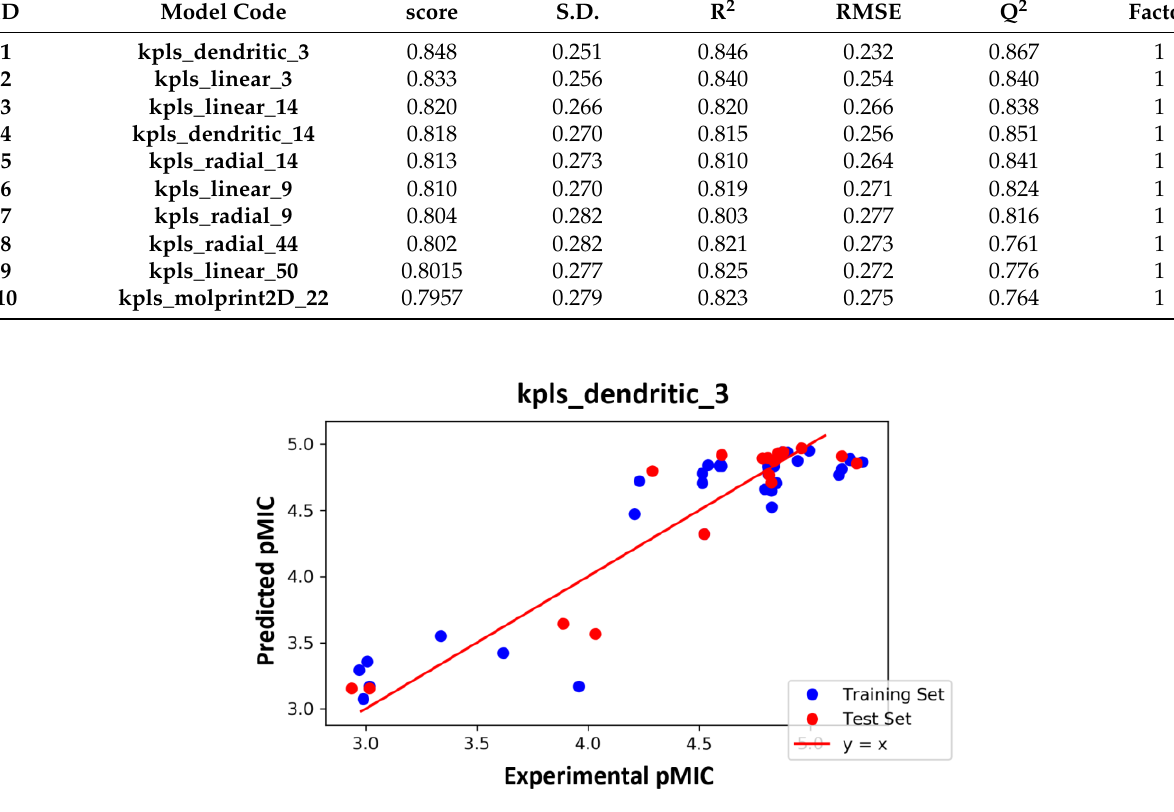
Figure 6. The scatter plot of observed and predicted values.